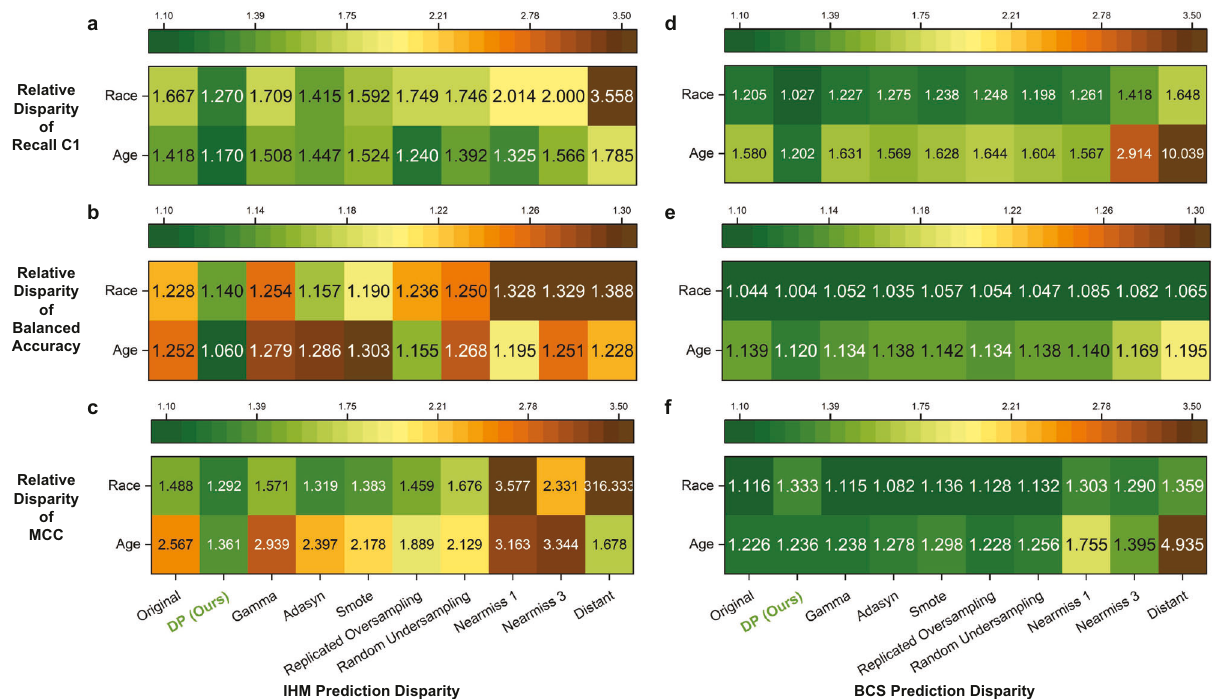
Fig. 5 Relative disparity among racial and age groups under various sampling conditions, including DP and the original machine learning model without any sampling. Relative disparity of MIMIC III IHM prediction in terms of a minority class recall, b balanced accuracy, and c Matthews correlation coef fi cient (MCC). Relative disparity of SEER BCS prediction in terms of d minority class recall, e balanced accuracy, and f Matthews Correlation Coef fi cient (MCC). DP performs the best in reducing the relative disparity across subgroups (i.e., showing the lowest disparity values) compared to the original model and models with other existing sampling methods for both